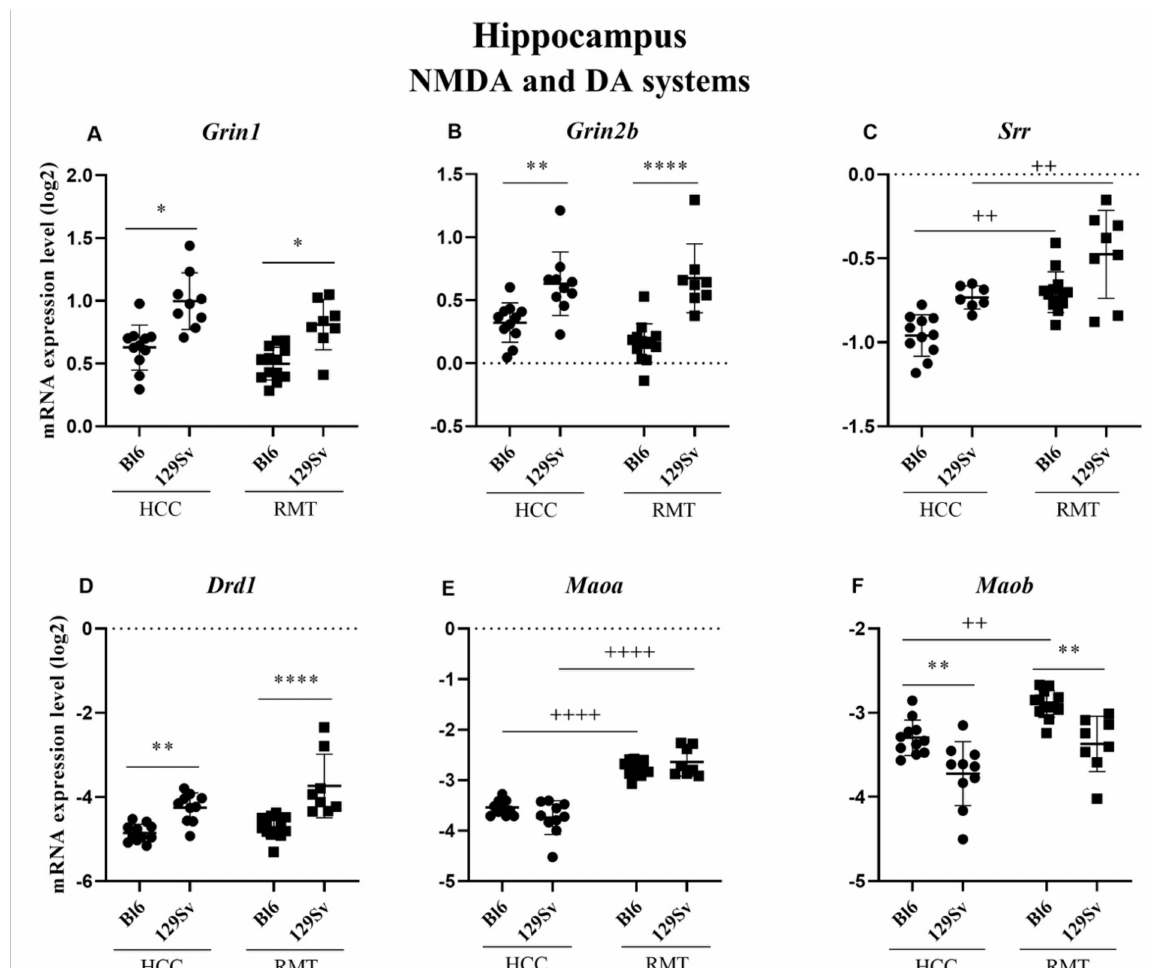
Figure 7. NMDA and DA systems gene expression in the hippocampus of Bl6 and 129Sv mice. Two-way ANOVA was applied to demonstrate differences between the strains and environments. Substantial statistically significant gene expressions for ( A ) Grin1 —glutamate ionotropic receptor NMDA type subunit 1, ( B ) Grin2b —glutamate ionotropic receptor NMDA type subunit 2B, ( C ) Srr —serine racemase, ( D ) Drd1 —dopamine receptor D1, ( E ) Maoa —monoamine oxidase A and ( F ) Maob —monoamine oxidase B. Bonferroni post hoc test: * p ≤ 0.05, ** p ≤ 0.01 and **** p ≤ 0.0001 compared to the respective 129Sv mice, ++ p ≤ 0.01 and ++++ p ≤ 0.0001 in strain specific comparison. Data are expressed as mean values ± SD. Number of animals in each group varied from 7 to